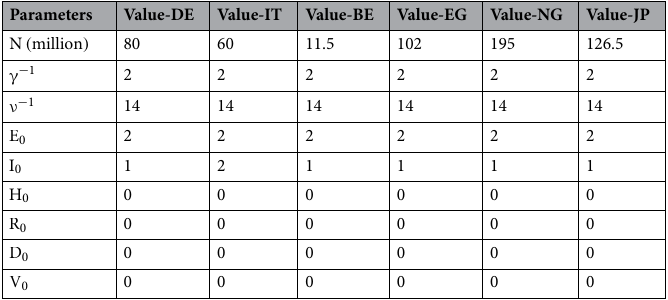
Table 2. Parameters estimated from the observed data in Germany (DE), Italy (IT), Belguim (BE), Egypt (Eg), Nigeria (NG) and Japan (JP) inferred from the World Health Organization.